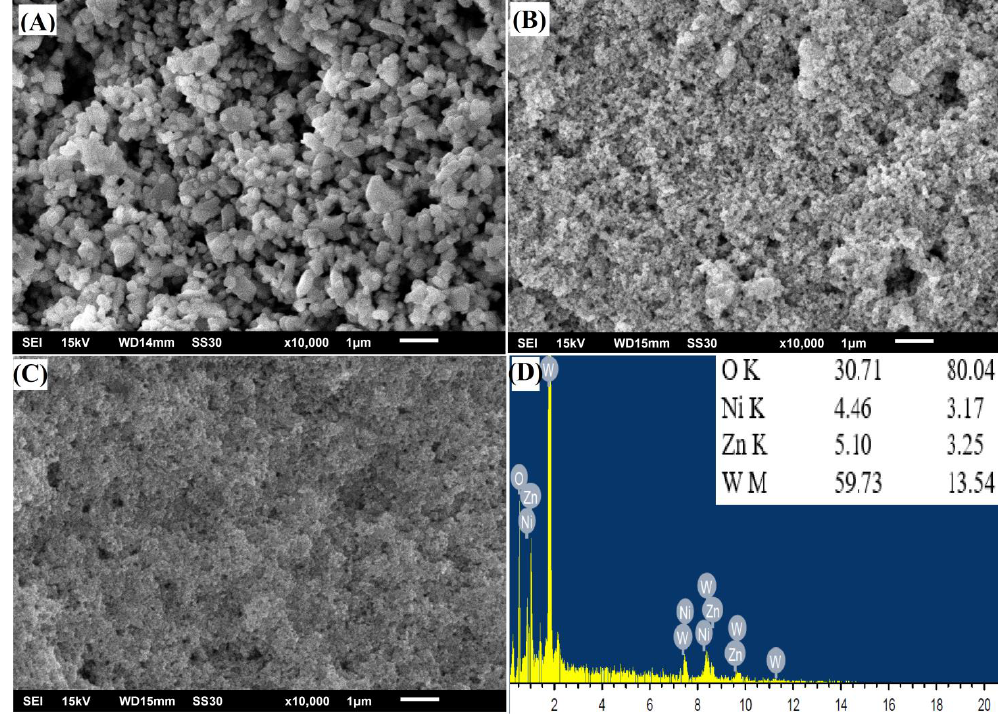
Figure 3D. Figure 4 shows the selected area mapping of the ZnNiWO 4 NPs showing the uniform distribution of O, Zn, Ni, and W across the crystal structure.